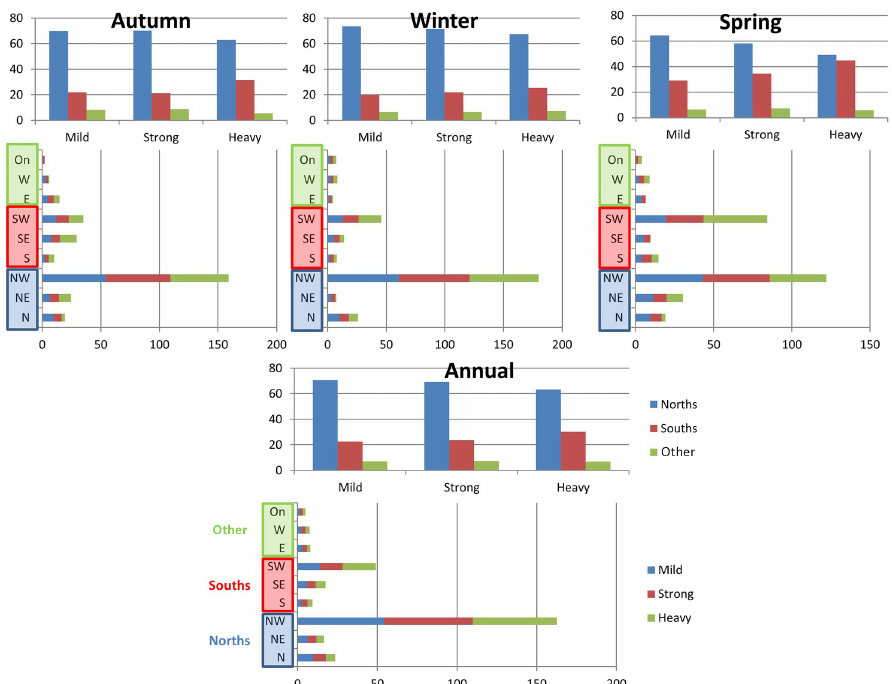
Figure 4. Annual and seasonal relative frequency (%) of the origination of cyclones affecting Crete, 1979–2011. The stacked bar diagrams concern every sector and the simple bar diagrams are the grouped results for north (N, NE, NW), south (S, SE, SW) and the remaining (E, W, On) sectors. On represents cyclones located within the Crete